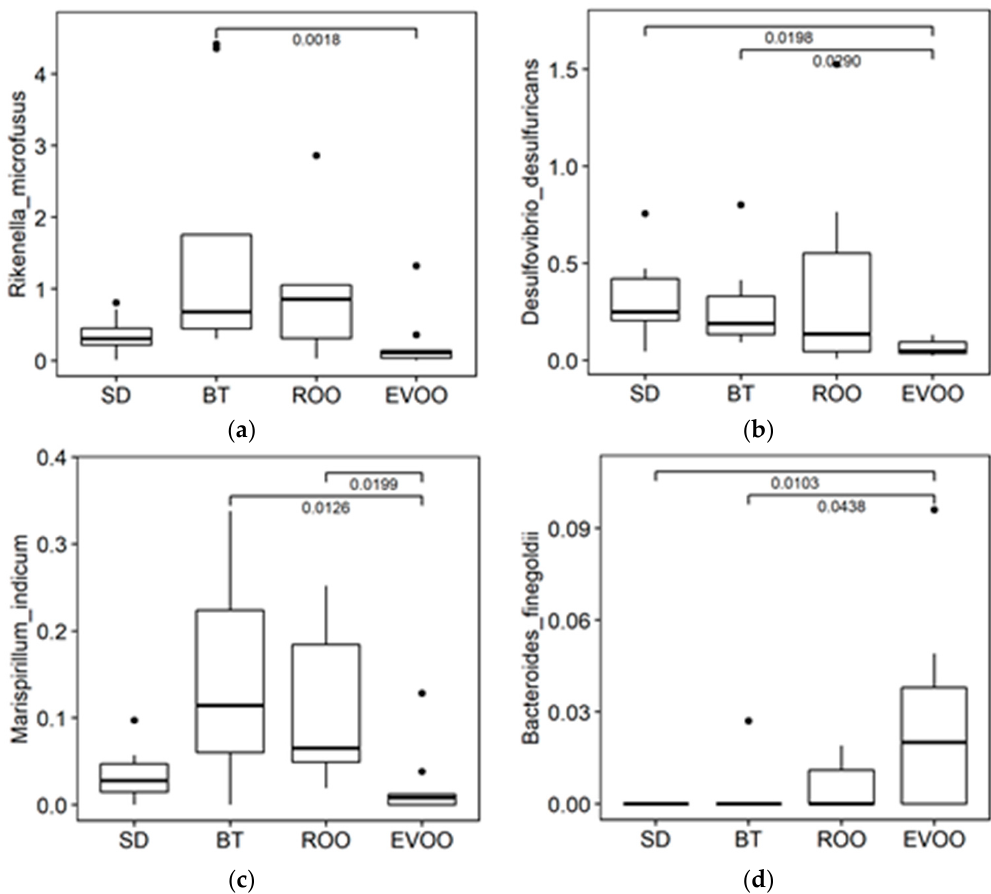
Figure 6. Box plot representation of the percentage distribution of the four species ( a ) Rikenella microfusus , ( b ) Desulfovibrio desulfuricans , ( c ) Marispirillum indicum , ( d ) Bacteroides finegoldii , with significant differences ( p < 0.05) between mice fed a diet enriched with butter (BT) and a diet enriched in virgin olive oil (EVOO). SD, standard chow. ROO, refined olive oil.